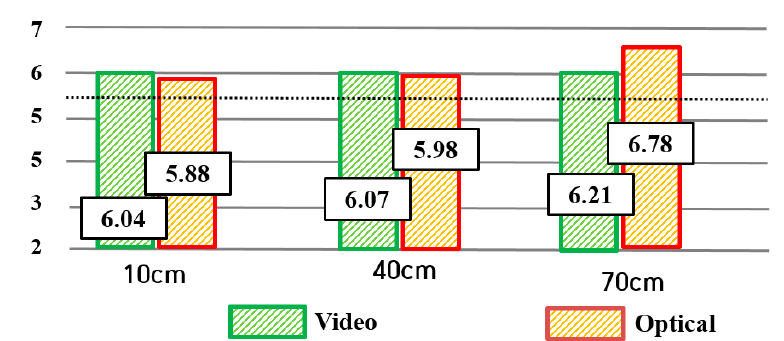
Figure 8. Results regarding scale perception. The subjects underestimated the virtual cube, compared with the real cube (5.5 cm), when using two MR devices (video and optical HMD type). Statistically significant differences between all distance conditions were not found ( p > 0.05). However, in the case of 70 cm, as a result of the T-test, it was found that there was a significant difference between the two HMDs ( p < 0.05).